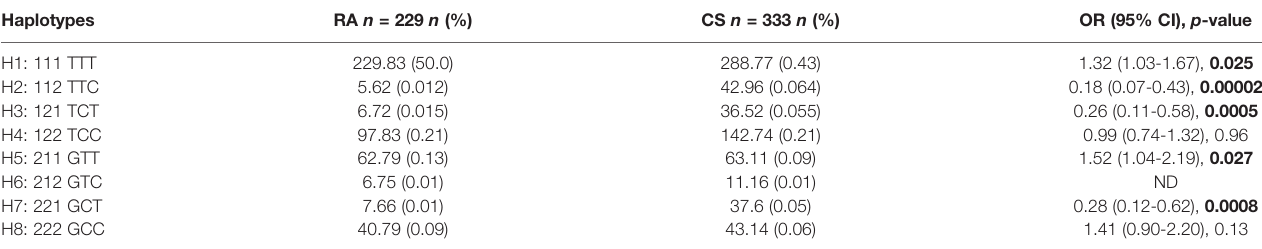
TABLE 4 | Haplotype frequencies of three PADI2 SNPs in RA and CS. Haplotypes